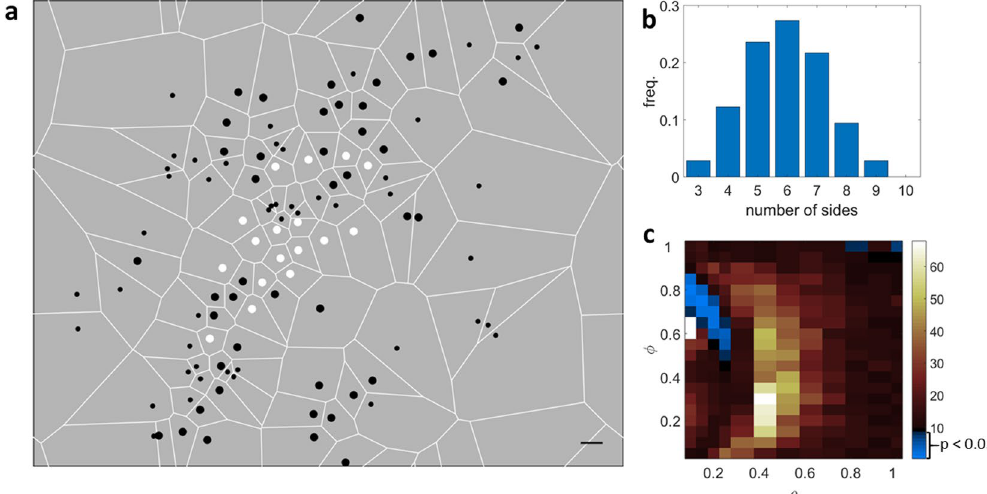
Figure 3. Comparison between the distribution of the number of nearest neighbors in a real population of MacQueens Bustard and in our model. ( a ) Spatial distribution of the display sites in the exploded lek of a population of MacQueen’s Bustard 19 . White circles represent radio-tagged individuals, black circles non- tagged individuals and dots undetermined observations. White lines delimit the Voroni cells generated by the population. Scale bar: 1 km. ( b ) Frequency distribution of the number of nearest neighbors for the spatial distribution shown in a, calculated as the number of sides of the associated Voronoi cells. ( c ) χ 2 test-statistic calculated from the deviations between the observed frequency distribution shown in b and those expected from our model. The region where the null hypothesis can be accepted (assuming a significance level of 0.05) is highlighted in blue. The white regions correspond to combinations of parameters where a stable configuration was not attained after 4 × 10 6 simulation